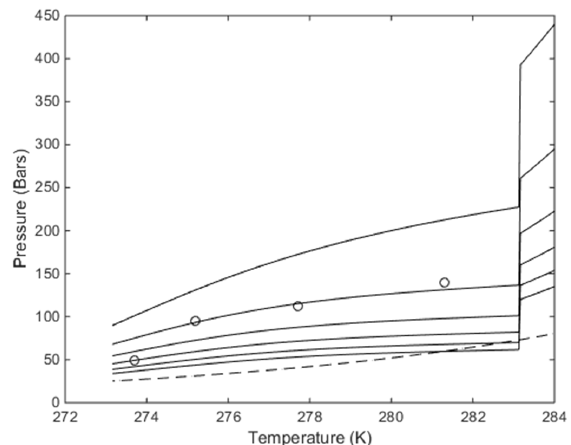
Figure 13. Calculated stability limits for hydrate in temperature pressure projection of the hydrate stability window. Lowest solid curve is for 30 mole per cent CO 2 , followed by 25 mole per cent CO 2 , then 20 mole per cent CO 2, , then 15 mole per cent CO 2 , then 10 mole per cent CO 2 and upper solid curve for 5 mole per cent CO 2 . The circles are experimental data from [54] for 10 mole per cent CO 2 , and as such to be compared to the second solid curve from top. Dashed curve temperature pressure stability limits for CH 4 hydrate.